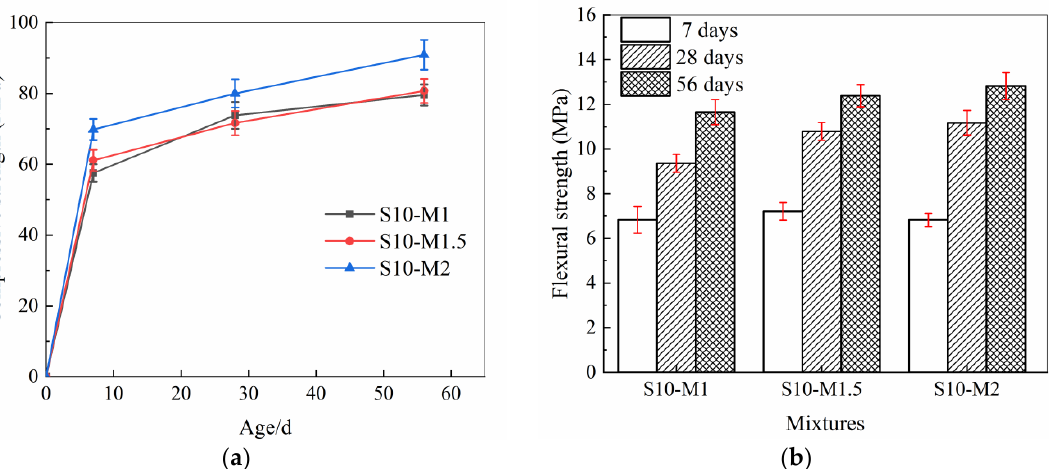
Figure 7. Effects of modulus M S on compressive strength ( a ) and flexural strength ( b ) of AASSC.